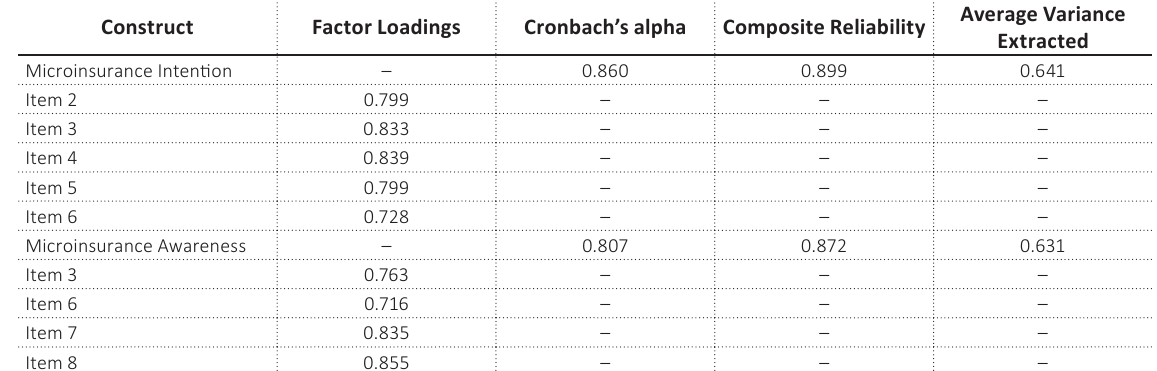
Table 2. Constructs’ reliability and validity